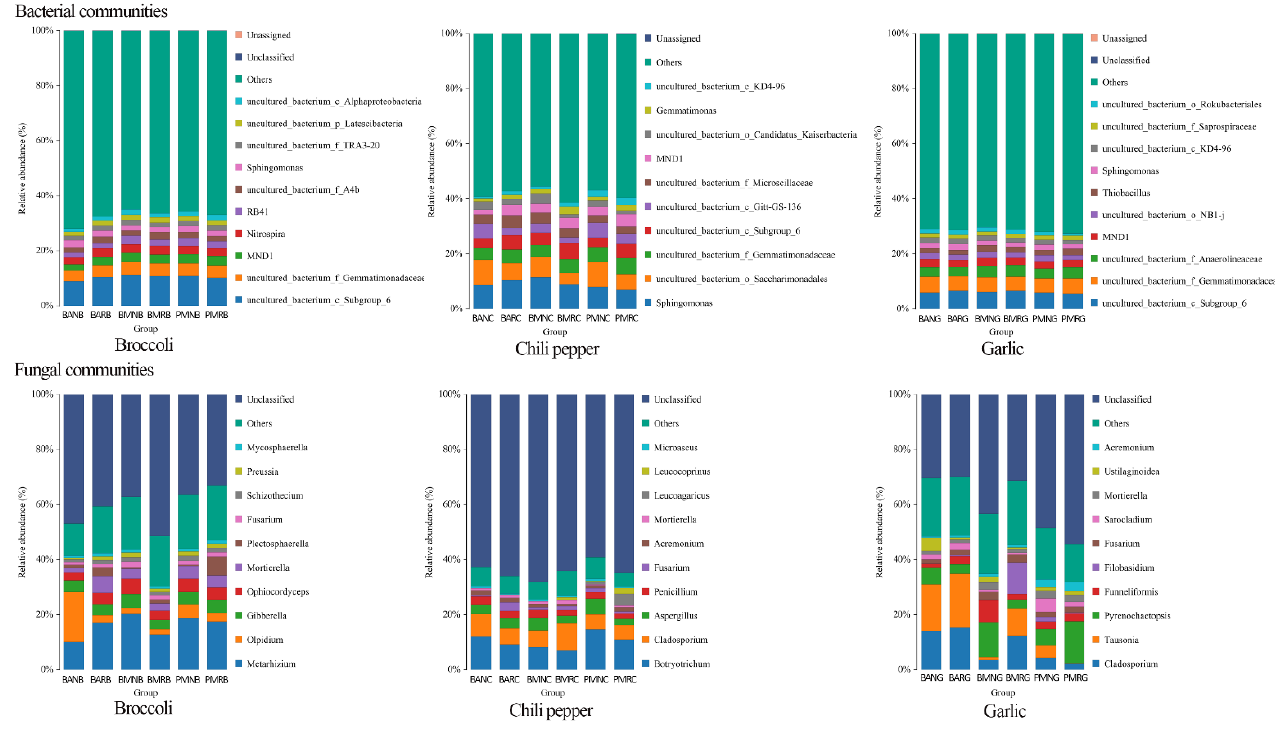
Figure 6. The composition and relative abundance of bacterial and fungal communities at genus level in three different vegetable fields under different treatments.